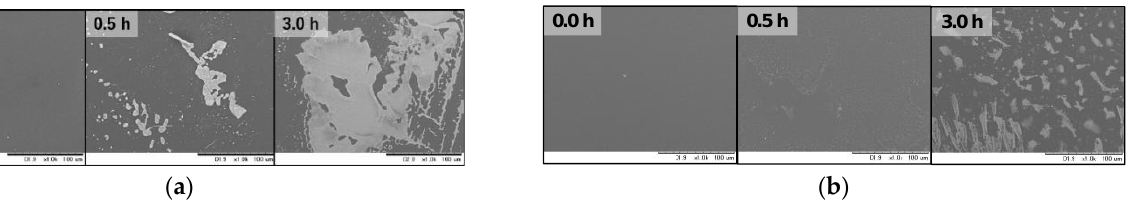
Figure 8. SEM image of the glass substrate immersed in AgNO 3 solution. ( a ) With biofilm formation; ( b ) Without biofilm